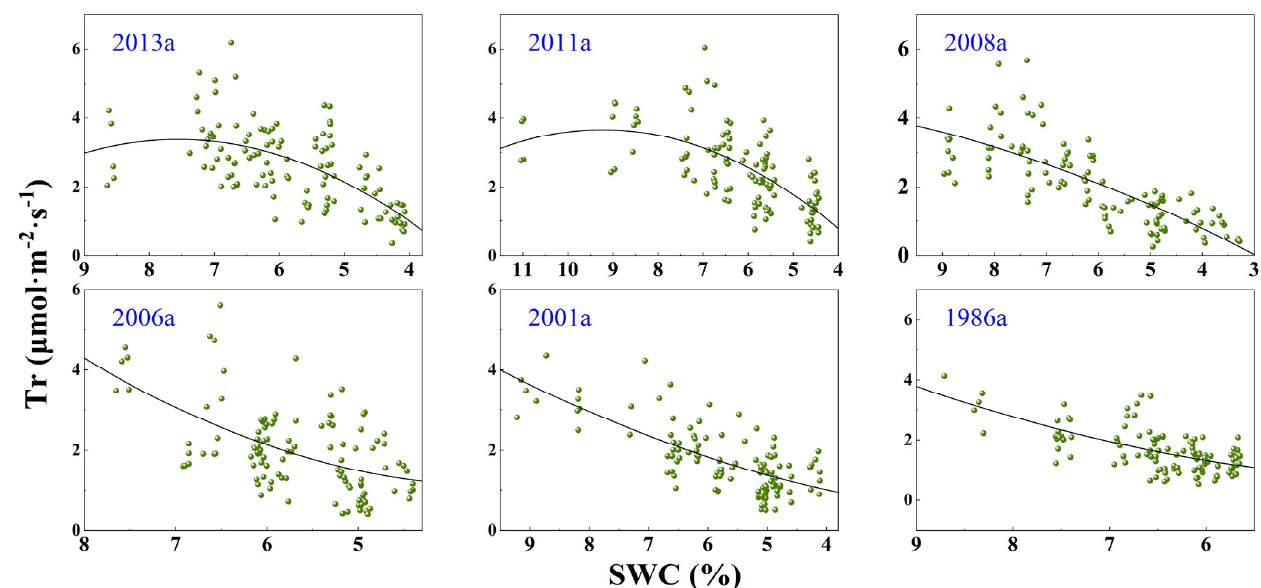
Figure 4. Regression fitting diagram of gs and SWC.